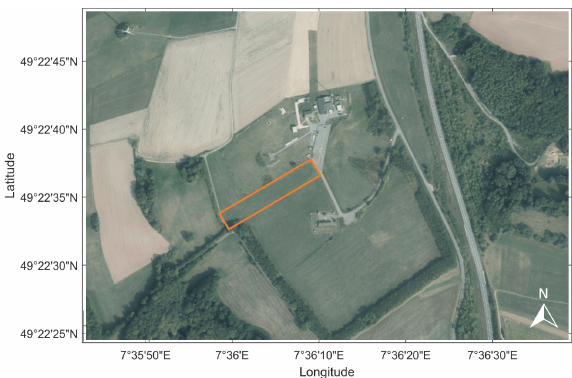
Figure 1. Optical image of the POLYGONE scene.